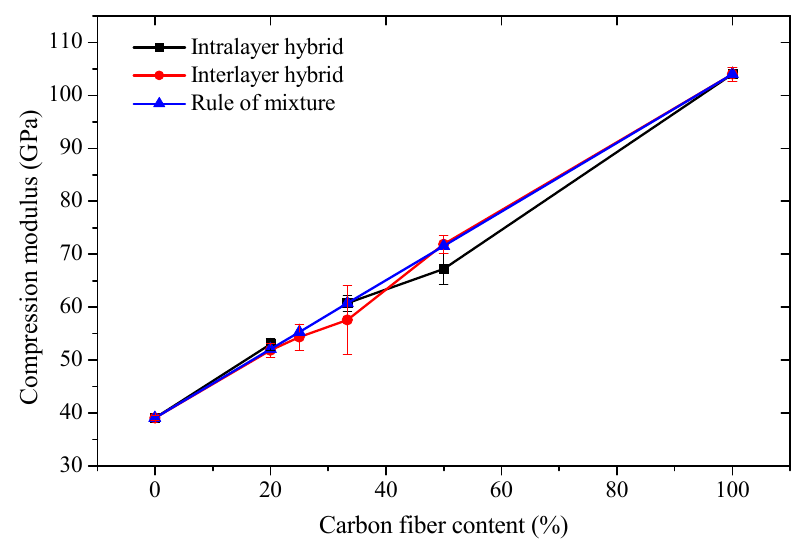
Figure 11. Interlayer and intralayer compression modulus attained by experiment and rule of mixture (ROM).